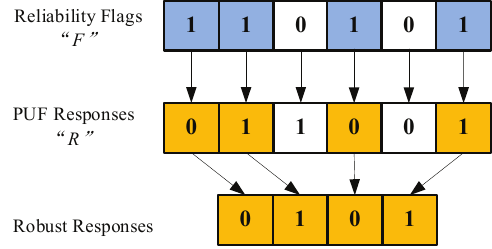
Figure 3. Extraction of robust